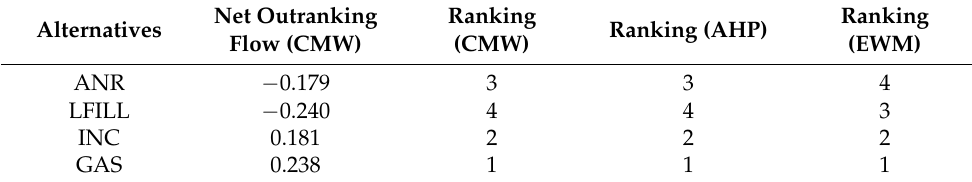
Table 10. Ranking of the